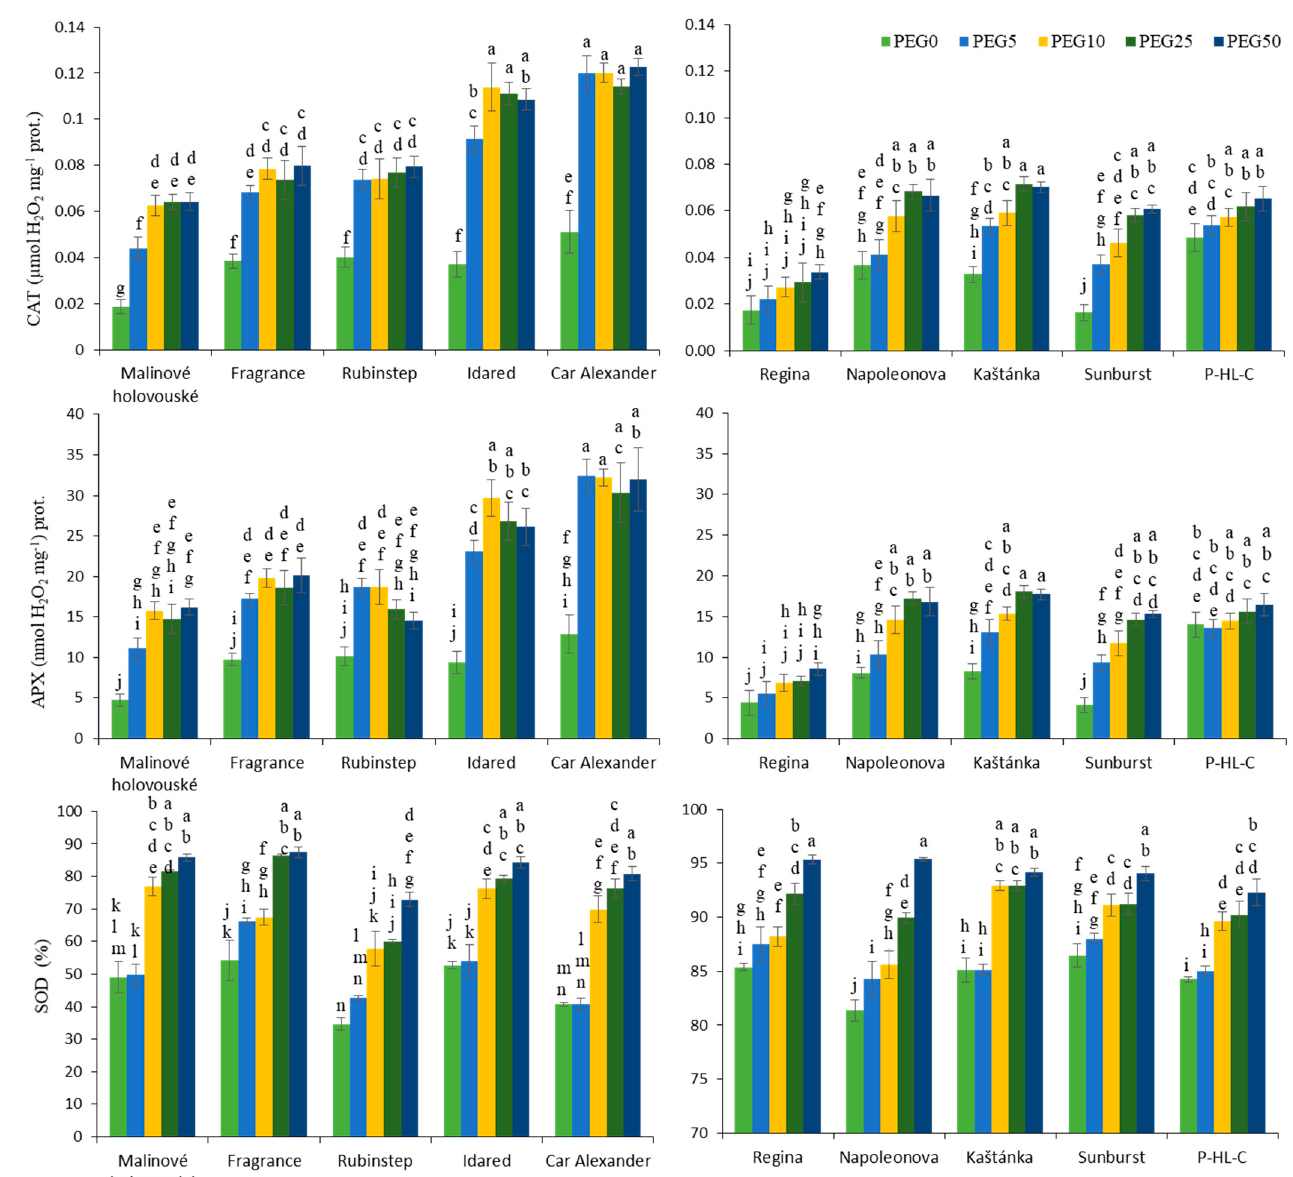
Figure 6. Effect of PEG-6000 concentration on catalase activity CAT ( µ mol H 2 O 2 g − 1 FW), ascorbate peroxidase activity APX (nmol H 2 O 2 g − 1 FW), and superoxide dismutase activity SOD (%) for in vitro culture of apple ( left ) and cherry ( right ) cultivars. Error bars represent standard deviation (SD). Values within column, followed by the same letter(s), are not significantly different according to Tukey’s test ( p < 0.05).